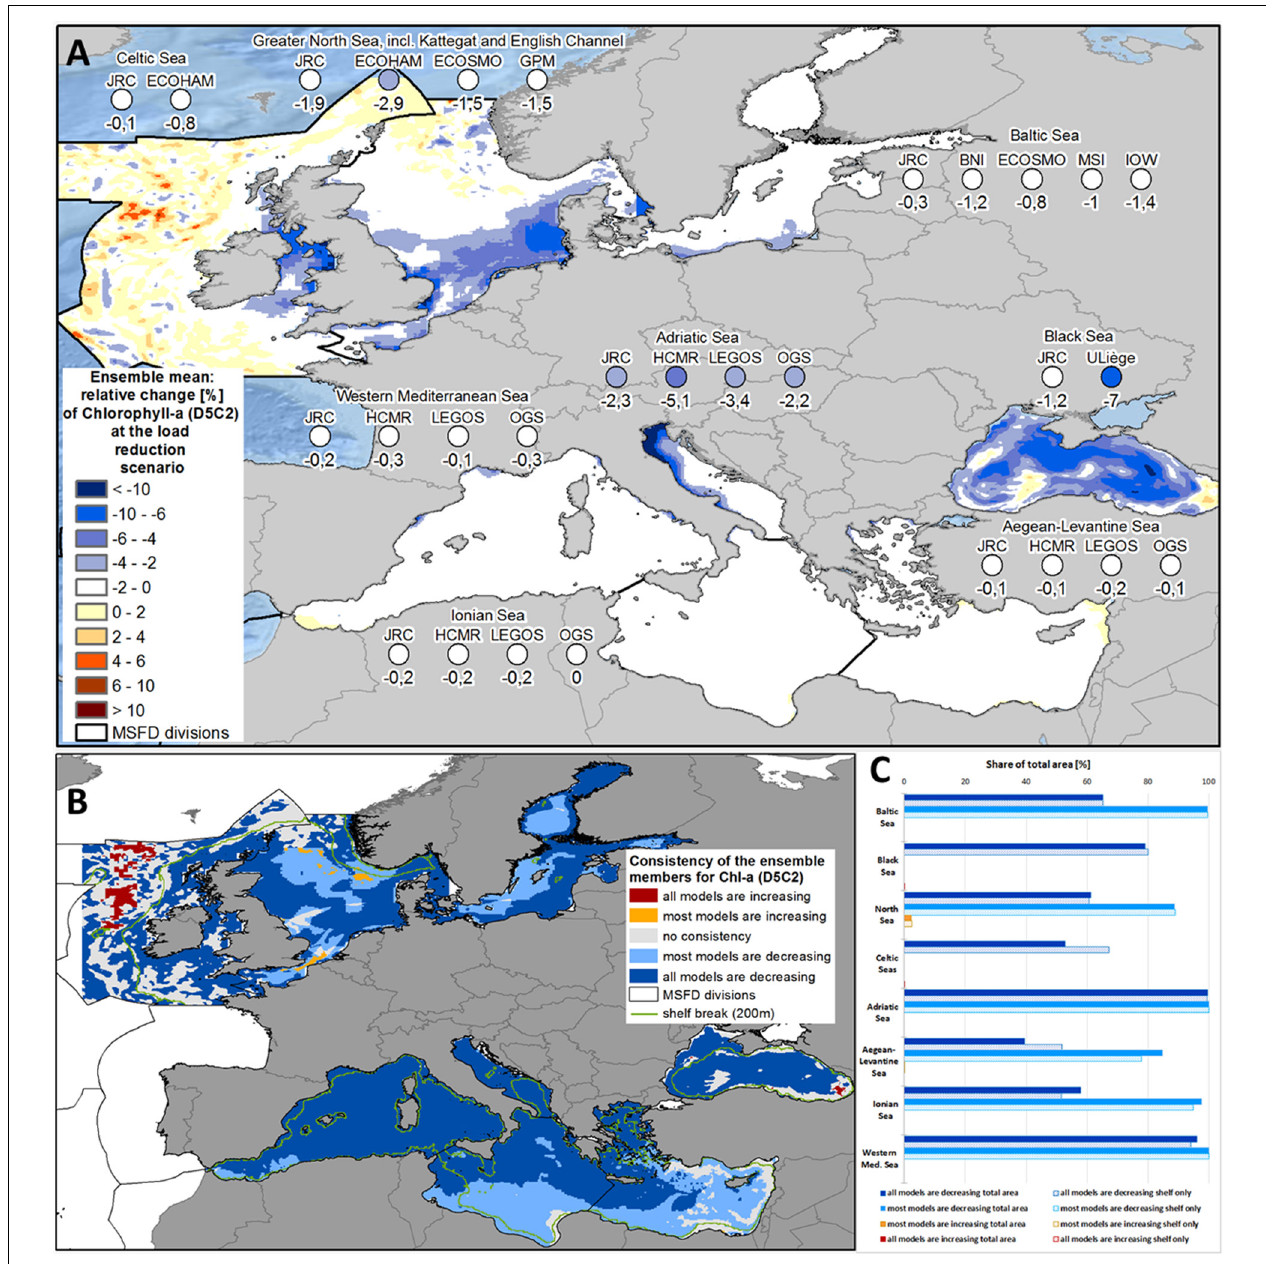
FIGURE 4 | (A) Ensemble means and model-specific relative change at load reduction scenario (compared to reference scenario) for the MSFD regions of chlorophyll-a (MSFD indicator D5C2). (B) Consistency map showing, if all or at least most models have the same trend of the relative change at load reduction scenario (compared to reference scenario) with respect to chlorophyll-a (MSFD indicator D5C2). (C) Share of the total area (bold bars) and of the shelf region (dotted bar), where all or most models show consistent changes with respect to chlorophyll-a (MSFD indicator